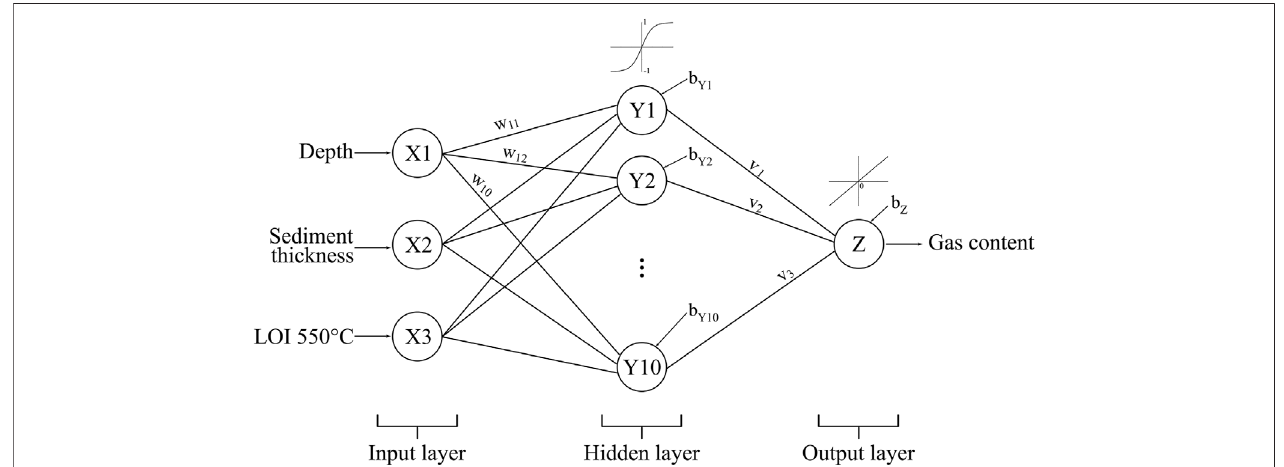
FIGURE2| Architectureofthearti fi cialneuralnetworkimplementedinthisstudyforthepredictionofgascontentinsediment.X1,X2,andX3aretheneuronsinthe inputlayer,Y1toY10aretheneuronsinthehidden,Zistheneuronattheoutputlayer.wdenotestheweightofeachneuronconnectionfromtheinputtothehiddenlayer, v are the weights of hidden layer connections to the output layer, and b are the bias for each neuron in the hidden and output layers.